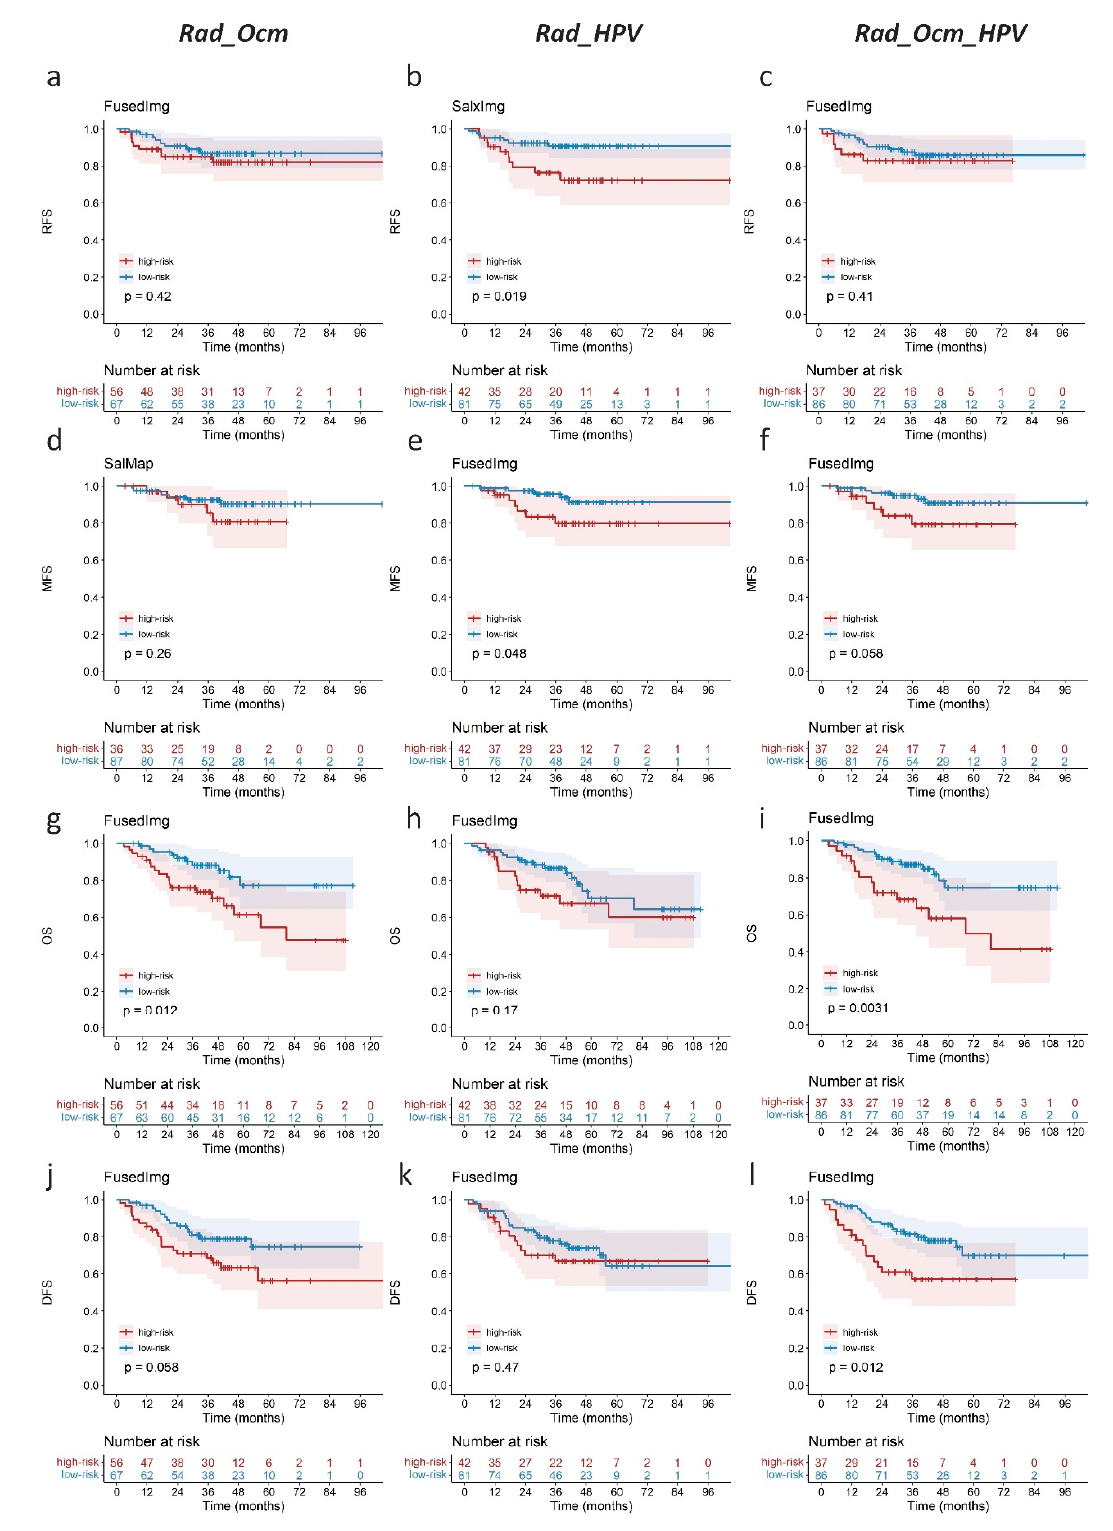
Figure 6. The K ‐ M curves of ( a , d , g , j ) Rad_Ocm, ( b , e , h , k ) Rad_HPV, and ( c , f , i , l ) Rad_Ocm_HPV model for RFS, MFS, OS, and DFS predictions in 123 OPC patients from testing cohort as listed in